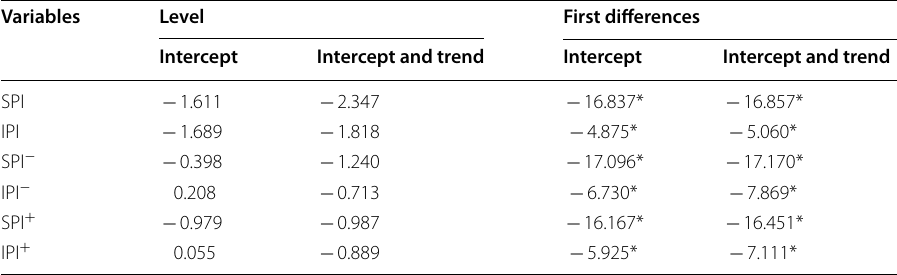
Critical values for the CIPS panel unit root test with an intercept term at 10%, 5%, and 1% levels are and 2.53, and with an intercept and a trend term are 2.72, − *The significance at the 1% level Table 4 Results of cross-sectional dependence tests for the panel causality test equations